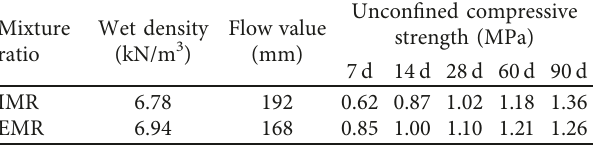
Table 3: Test results of fluidity, wet density, and compressive strength.